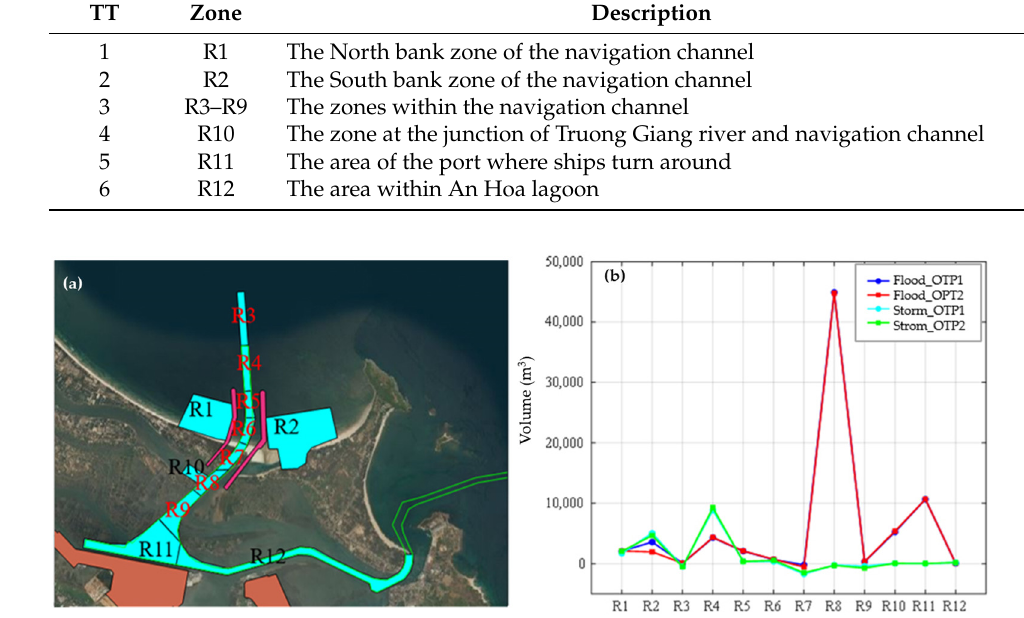
Figure 26. ( a ) Twelve zones for sedimentation and erosion analysis, ( b ) amount of sediment deposited under two alternatives. Table 3. Zoning of the areas for sedimentation and erosion analysis. TT Zone Description R1 The North bank zone of the navigation channel